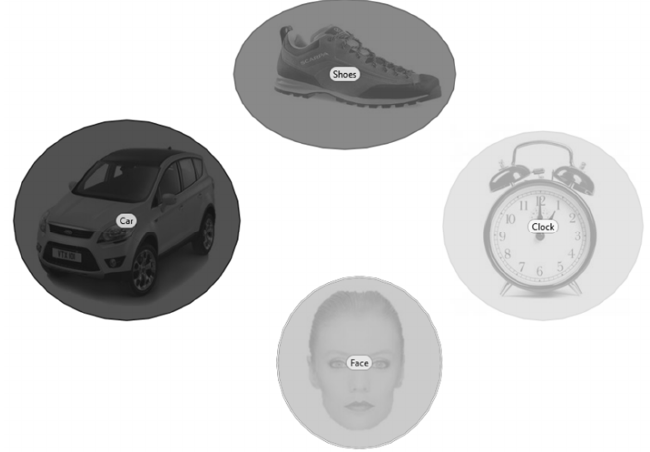
Figure 2. Example of AOIs.